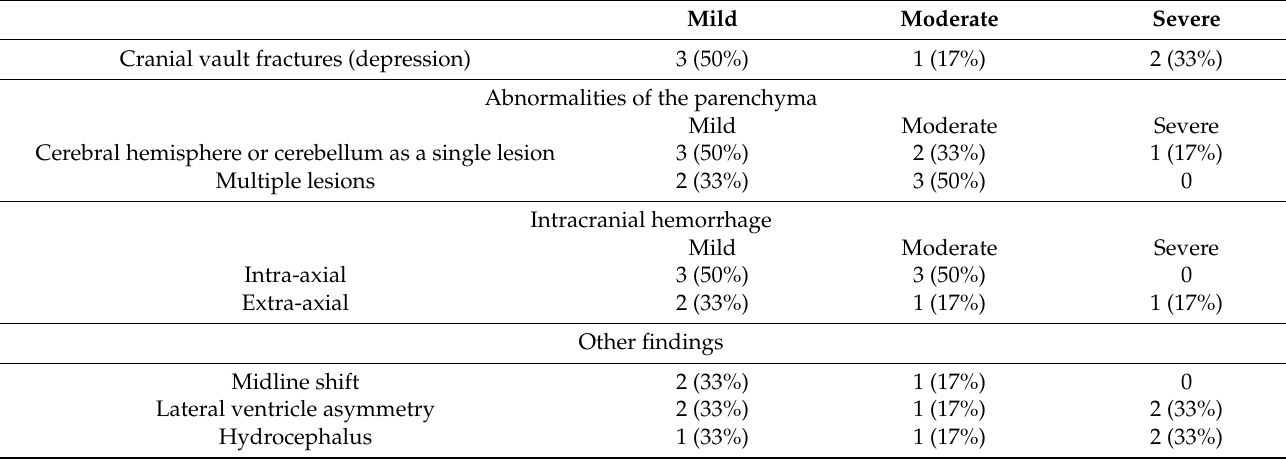
Table 2. Computed tomography (CT)